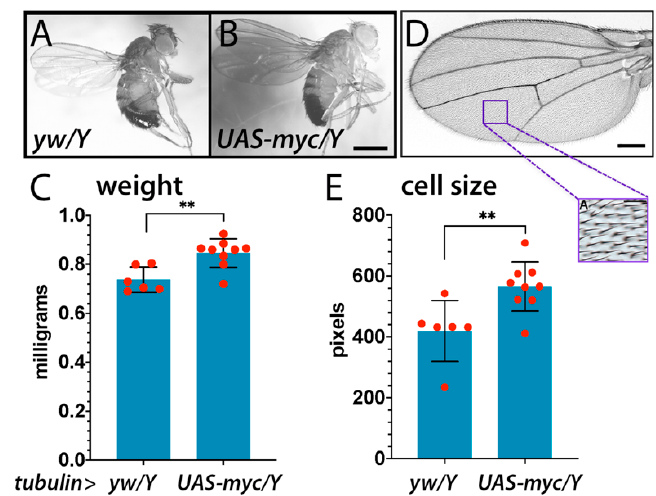
Figure 2. Myc ubiquitous expression increases animal weight and cell size. ( A – C ) Expression of Myc using the ubiquitous promoter tubulin ( tubulin > Gal4 ; UAS-Myc [33]) significantly increases body size and weight. ( A , B ) Photographs of control yw / Y males and animals expressing Myc ubiquitously ( UAS-Myc ) using the tubulin-Gal4 promoter; scale bar 1 mm. These flies were weighed, and the results are represented in the graph ( C ); as shown, expression of Myc increases body weight. ( D , E ) Myc expression increases cell size. The cell size was analyzed in the adult wing by measuring the number of the trichomes present in the wing blades of animals of the di ff erent genotypes (control yw / Y males and animals expressing Myc ubiquitously using the tubulin-Gal4 promoter). Each cell of the epidermal surface of the wing carries a protrusion called trichome, that is visible in the adult wing. The number of trichomes is then equivalent to the number of cells from the epithelium. By considering a specific area of the wing (indicated by the square), and by measuring the number of trichomes present in the fixed square, it is possible to analyze the density of the trichomes, which is indirectly proportional to cell size (the higher the density, the smaller the cell size); scale bar 200 µ m. ( E ) Graph representing the calculated cell size from experiments in ( D ). Taking into account that the lower the number of trichomes in each square the larger is the cell size, these experiments concluded that expression of Myc increases the size of the animal because it increases the cell size, and not because it induces proliferation. The asterisks represent the p -values from t -test student ** = p < 0.01, the error bars indicate the standard deviations, the number of animals is indicated by the red dots. The same conclusion was observed in females.